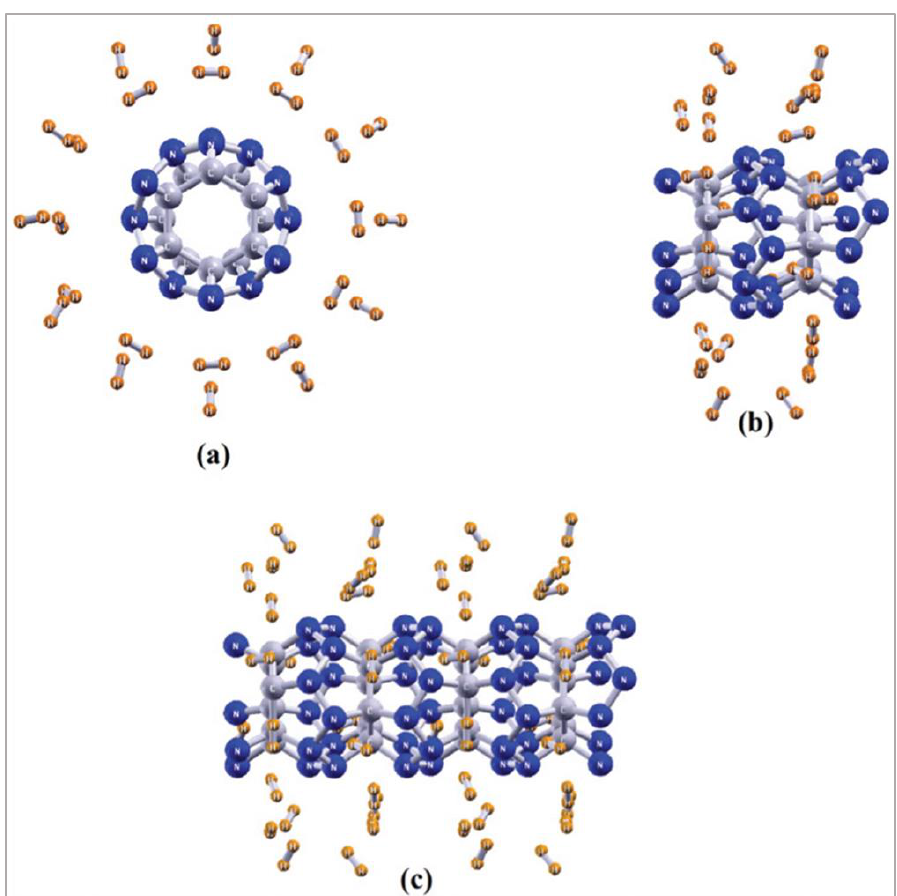
Figure 9. The segment ( a ) indicates the top view and the ( b ) marks the side view. The ( c ) represents a super cell form of the C 12 N 24 (H 2 ) 24 unit cell. This figure is reproduced from Reference [21].